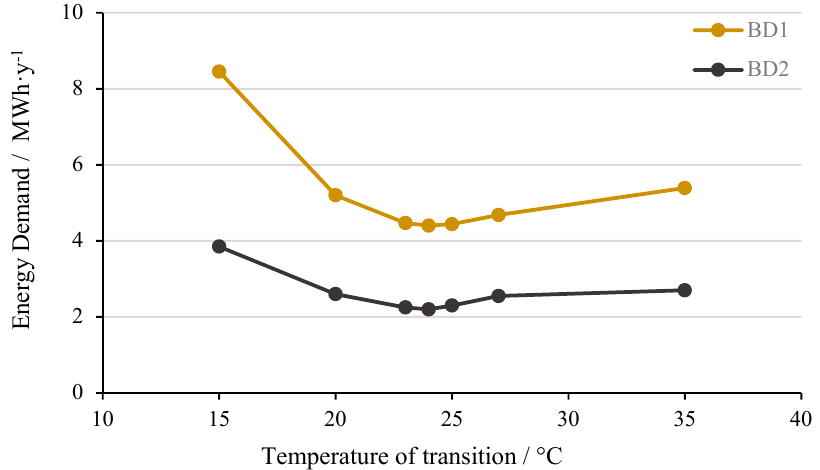
Figure 3. Annual energy demand, for building configurations BD1 and BD2, located in Porto, Portugal, considering different transition temperatures for the thermochromic paint.